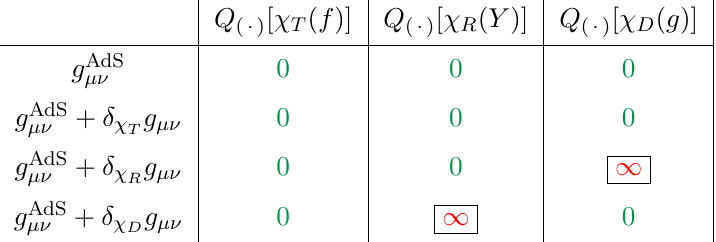
Table 8 . Gravitational Noether charges of the vectors χ p with p = T, R, D in (5.8) computed in a pure AdS background and the perturbed metrics in (5.25). The divergences in some of the